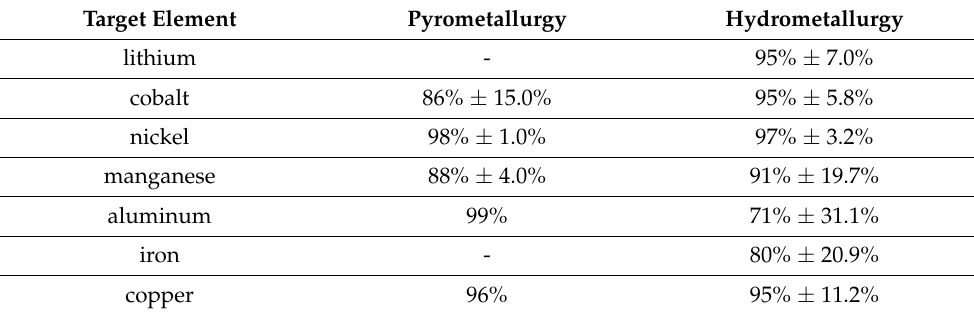
Table 3. Recovery efficiencies achieved by different recycling technologies